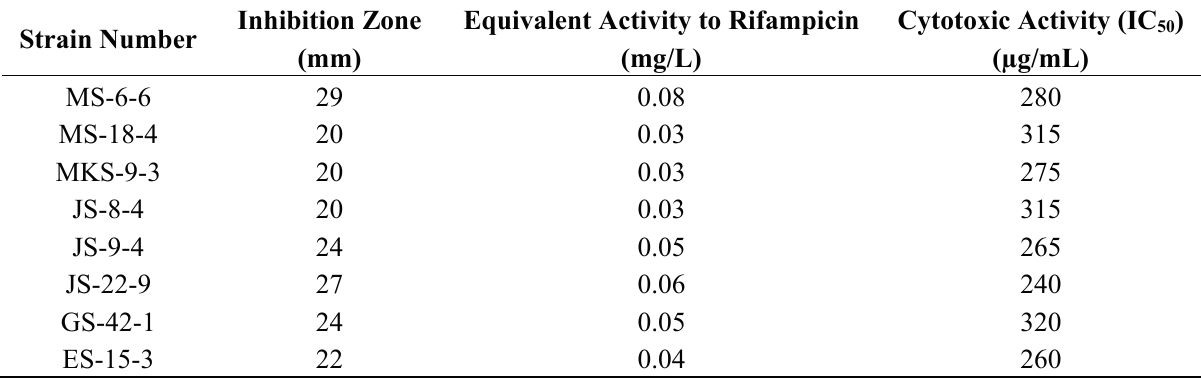
Table 1. The anti-tuberculous activity of the selected Streptomyces extracts and their cytotoxic activities against normal human fetal lung fibroblast cell line (MRC-5).